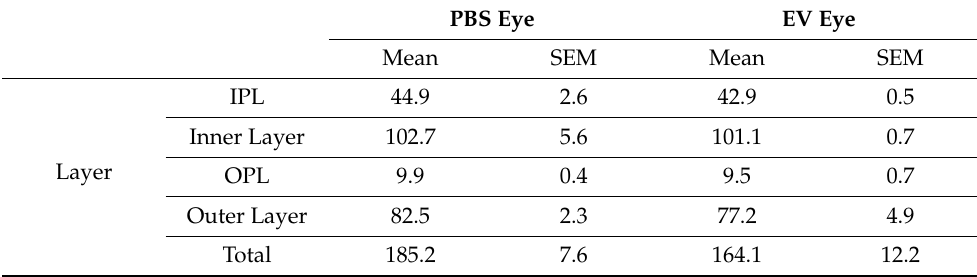
Table 1. Retinal histology after administration of EVs. For the EV toxicity study, histological sections (Figure 5) were stained with hematoxylin and eosin (H and E). One eye received PBS, the other EVs. N = 5. There were no significant changes in retinal layer thicknesses, measured in µ m. IPL = inner plexiform layer, OPL = outer plexiform layer, SEM = standard error of the mean. PBS Eye